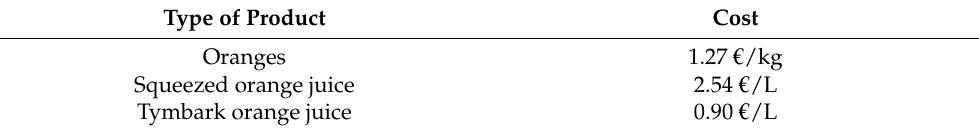
Table 6. Cost of oranges and orange